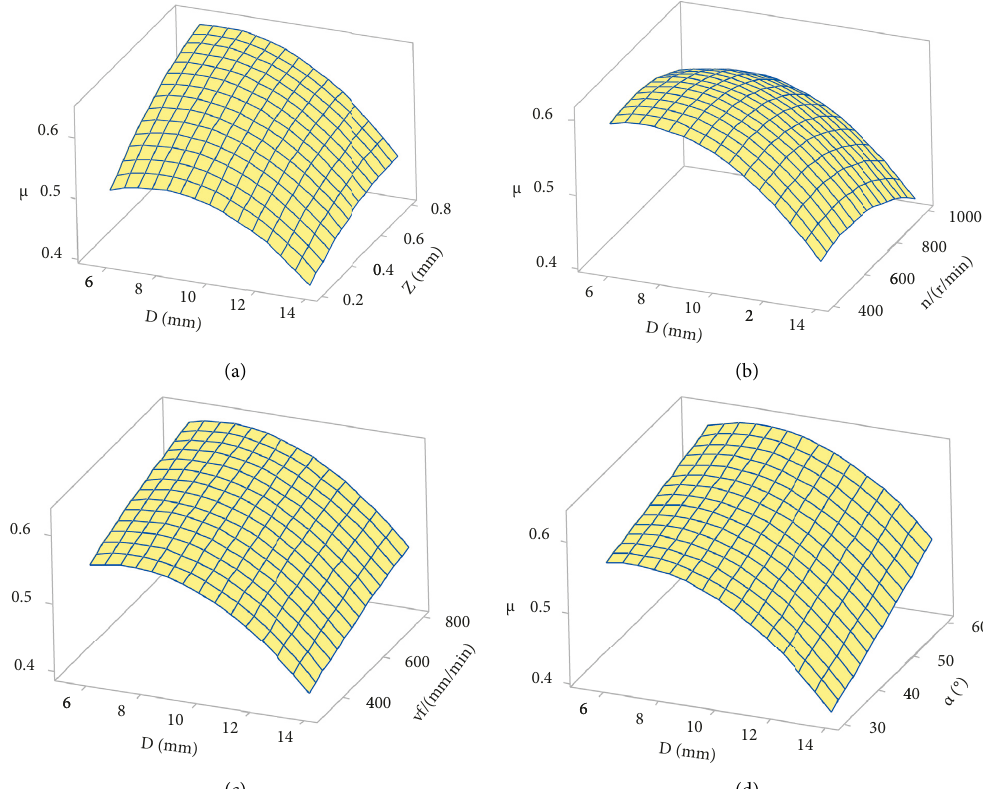
Figure 17: RS for D interacting with Z , n , vf, and α , respectively. (a) μ � f ( D , Z ). (b) μ � f ( D , n ). (c) μ � f ( D , vf). (d) μ � f ( D , α